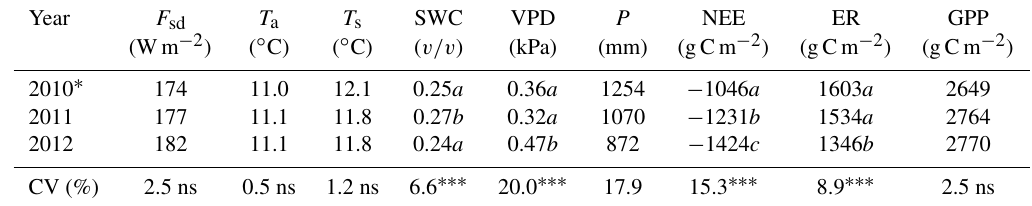
Table 2. Annual averages of incoming solar radiation ( F sd ), air temperature ( T a ), soil temperature ( T s ), soil water content (SWC), vapour pressure deficit (VPD), annual sums of rainfall ( P ), net ecosystem exchange (NEE), ecosystem respiration (ER) and gross primary produc- tivity (GPP) at Wombat State Forest from 2010 to 2012; CV – coefficient of variation for inter-annual variation; inter-annual differences are indicated with ∗∗∗ ( p <0.001), ∗∗ ( p <0.01) or ns (not significant). Letters indicate year-to-year differences.